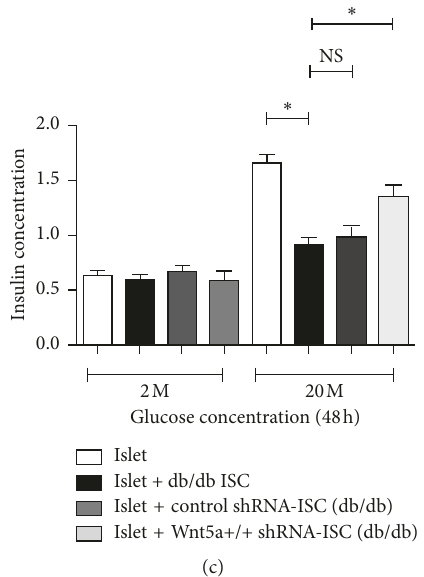
Figure 3: Wnt5a protein is a key modulator of ISC-mediated regulation of islet function. (a) A significant change in the mRNA expression of Wnt5a at 72 hours was caused by transfection of ISCs with shRNAs directly targeting Wnt5a when compared to control. All data were expressed as the means ± SE ( n � 3); ∗ P < 0 . 05; ∗∗ P < 0 . 01; shRNA Wnt5a-ISCs vs ISCs transfected with control nontargeting shRNAs. (b) Islets cocultured with Wnt5a − / − db/m ISCs had significantly reduced insulin secretion compared with control. All data were expressed as the means ± SE ( n � 3); ∗ P < 0 . 05; ∗∗ P < 0 . 01; shRNA Wnt5a − / − db/m ISCs vs db/m ISCs transfected with control nontargeting shRNAs. (c) The shRNA-induced upregulation of Wnt5a expression in hyperglycaemic db/db ISCs increased the insulin secretion compared with the control. All data were expressed as the means ± SE ( n � 3); ∗ P < 0 . 05; ∗∗ P < 0 . 01; shRNA Wnt5a+/+ db/db ISCs vs db/db ISCs transfected with control nontargeting